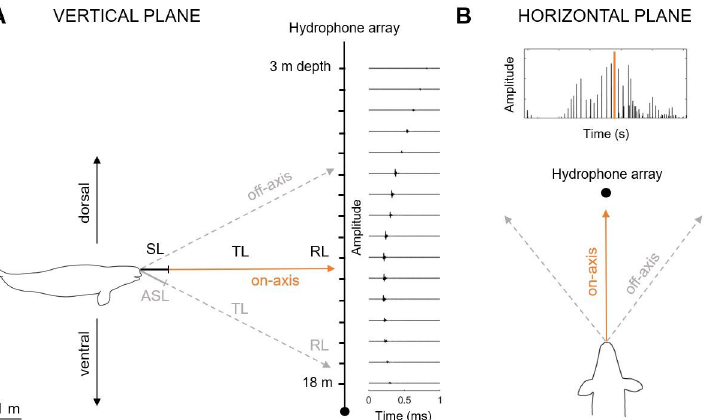
Fig 2. Schematic showing experimental setup and spatial criterion for on-axis click selection in the (A) vertical and (B) horizontal planes. The radiation pattern of an echolocation click is shown where the passive sonar equation was applied. The source level (SL) is the sound pressure level calculated from the received level (RL) and transmission loss (TL) on the acoustic axis; apparent source level (ASL) is the sound pressure level calculated for off-axis clicks/clicks of unknown recording aspect. Vertical on-axis clicks were isolated when the whale’s acoustic axis (i.e. the maximal intensity of the whale’s beam) was vertically centered on the array which was determined by -3dB beam width calculations. For each scanning sequence (i.e. click train with first ascending then descending amplitudes), the highest intensity click was isolated as a horizontal on-axis click where the whale was pointing its beam towards the array (not to the left or right), assuming constant